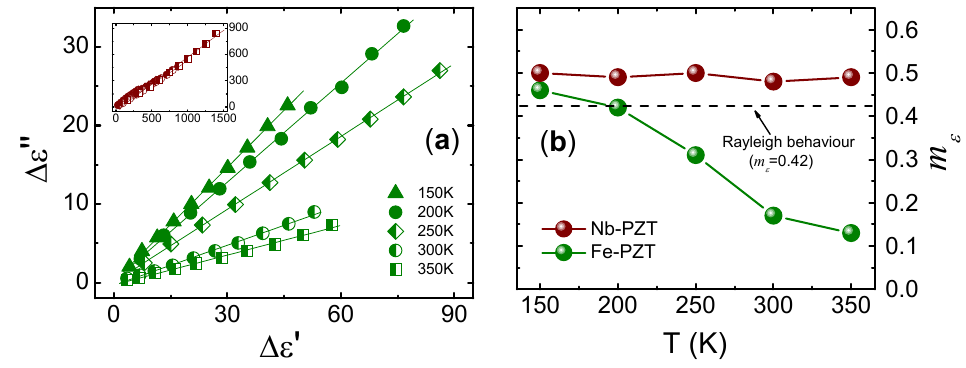
Figure 4. ( a ) Relation between the increments of the imaginary ( Δε″ ) and real ( Δε′ ) parts of the relative permittivity for Fe ‐ doped Pb(Zr 0.60 Ti 0.40 )O 3 (Fe ‐ PZT) at several temperatures. In the inset, this relation is shown for Nb ‐ doped Pb(Zr 0.60 Ti 0.40 )O 3 (Nb ‐ PZT) at the same temperatures. Linear fits are shown as solid lines; ( b ) Ratio between the increments of the imaginary and real parts of the permittivity ( m ε ) for both Fe ‐ PZT and Nb ‐ PZT at several temperatures. The data were extracted from the reference [38] (Copyright AIP Publishing LCC., 2012).